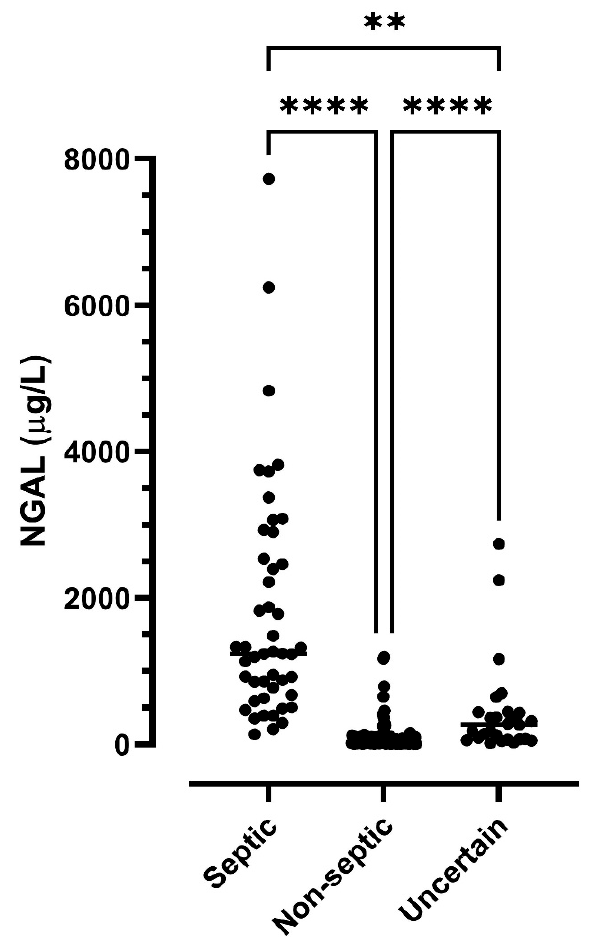
Figure 1. Concentrations of neutrophil gelatinase-associated lipocalin (NGAL) in synovial fluid samples from 152 horses suspected of septic synovitis. Samples were classified as septic ( n = 47), non-septic ( n = 103), or uncertain ( n = 27) based on total leukocyte count, differential leukocyte counts, total protein concentration, and the results of bacteriology. Asterisks show significant dif- ferences between groups, ** p < 0.01; **** p < 0.0001. Synovial fluid NGAL concentration correlated significantly with SF WBC ( p < 0.0001.